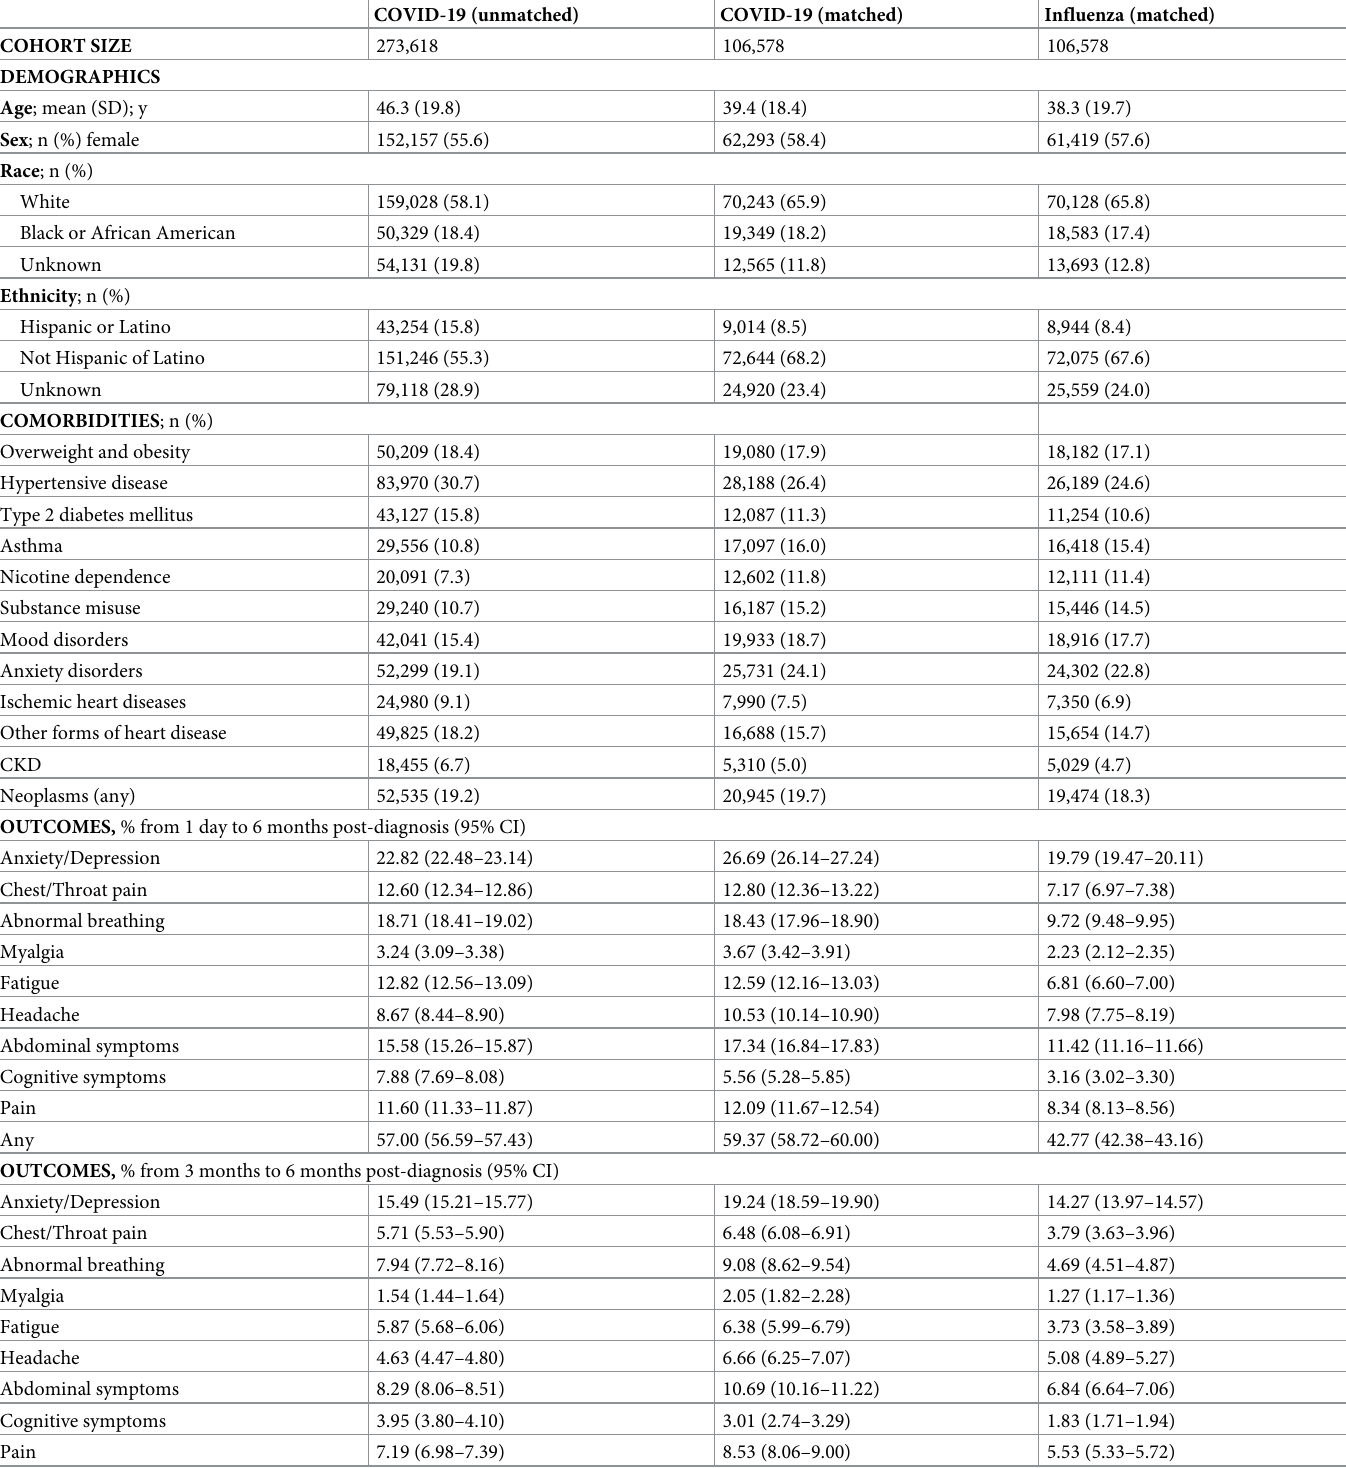
Table 1. COVID-19 cohort, and for COVID-19 and influenza cohorts after propensity score matching. Only characteristics with a prevalence higher than 5% in the unmatched COVID-19 cohort are presented here; for additional baseline characteristics and outcomes, see Tables A and B in S1